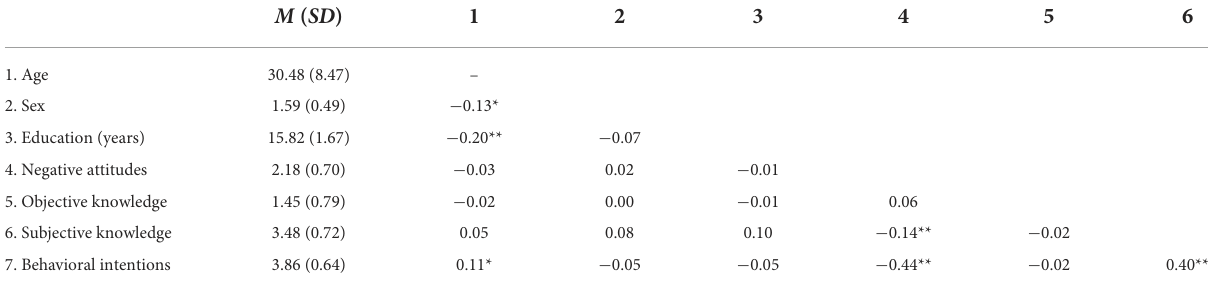
TABLE 6 Means, standard deviations, and correlations of study 2 variables ( N = 388).